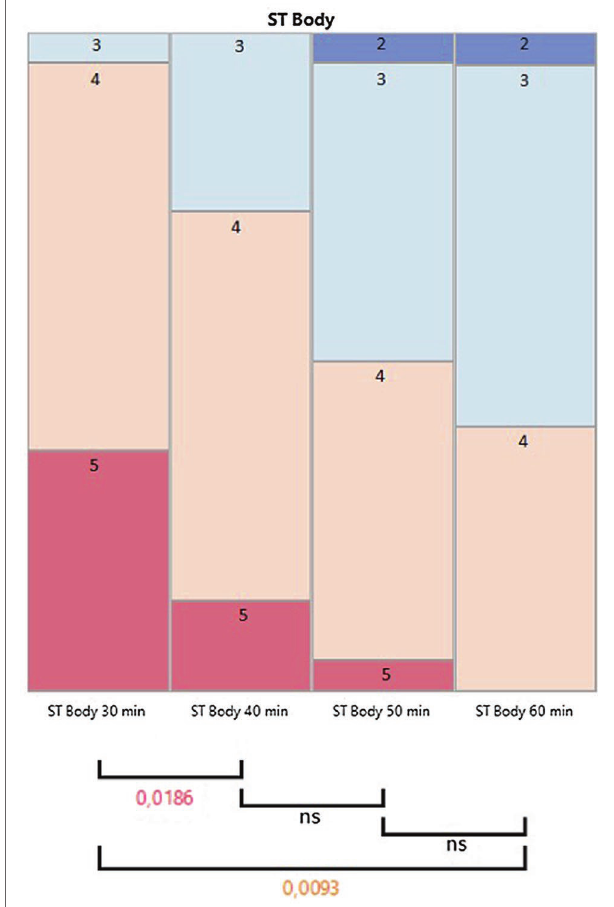
FIGURE 2 | Percentage variation of CFFF during and after the dive to 45 meters with CCR (low set point 0.7 and high set point 1.2, the diluent being trimix 19/40) in relation to pre-dive measurements. The pre-dive measurements are marked as the 100% reference line. Each subject is compared to his or her own measurements. The box plot represents quantiles, and the diamond represents the 95% confidence interval (*** p = < 0.0001, ns = not significant). Sample size is 20 in the pre-dive analysis and 17 in the pre-post analysis.